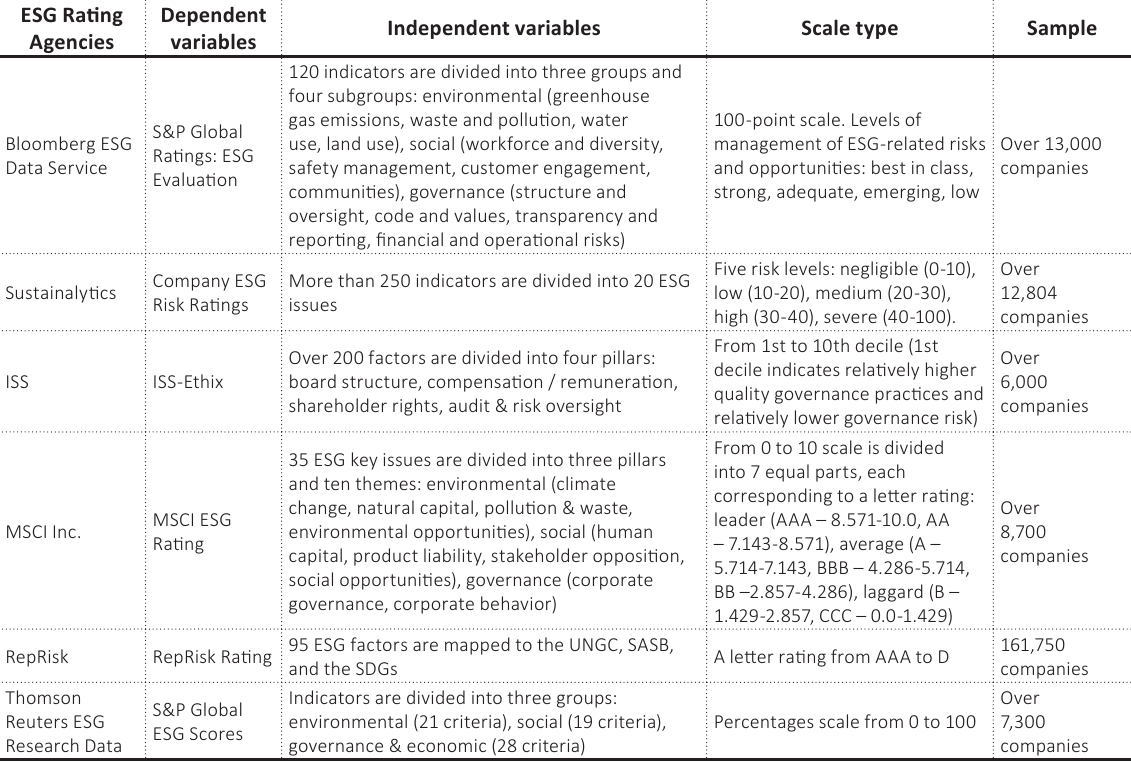
Table 1. Comparison of major ESG ratings Source: Composed by the author based on the websites of ESG Ratings Agencies